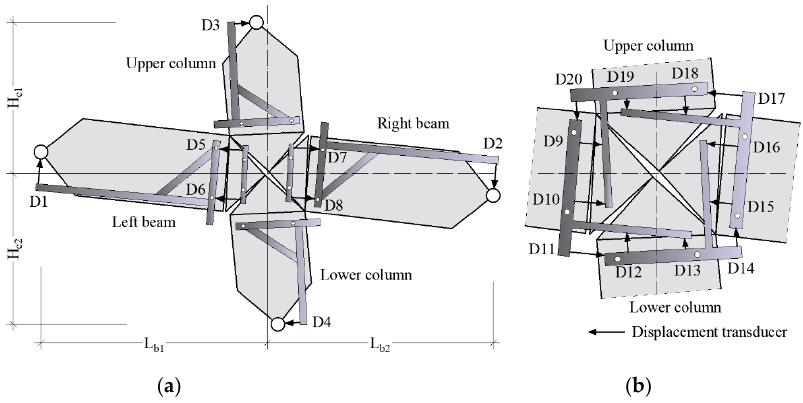
Figure 7. Measurement mechanism of the system: ( a ) For chord rotations and fixed end rotations; ( b ) For deformation of joint.